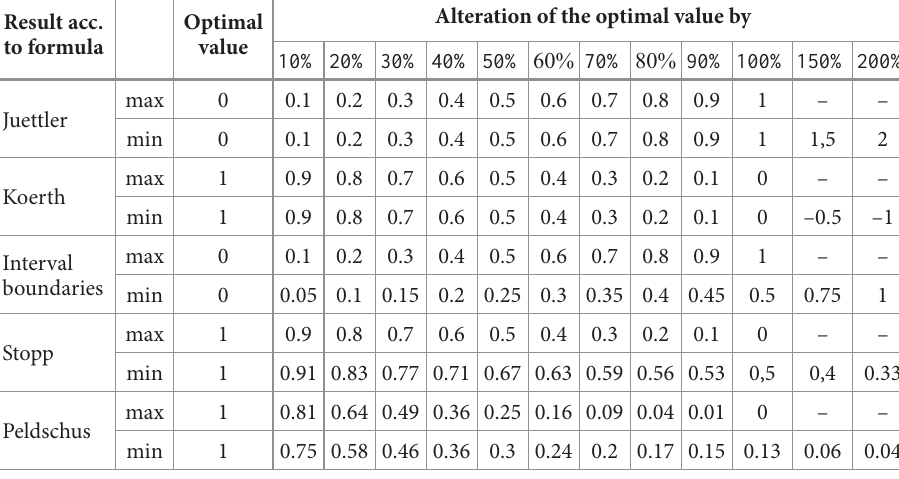
Table 1. Transformed values Result acc. to